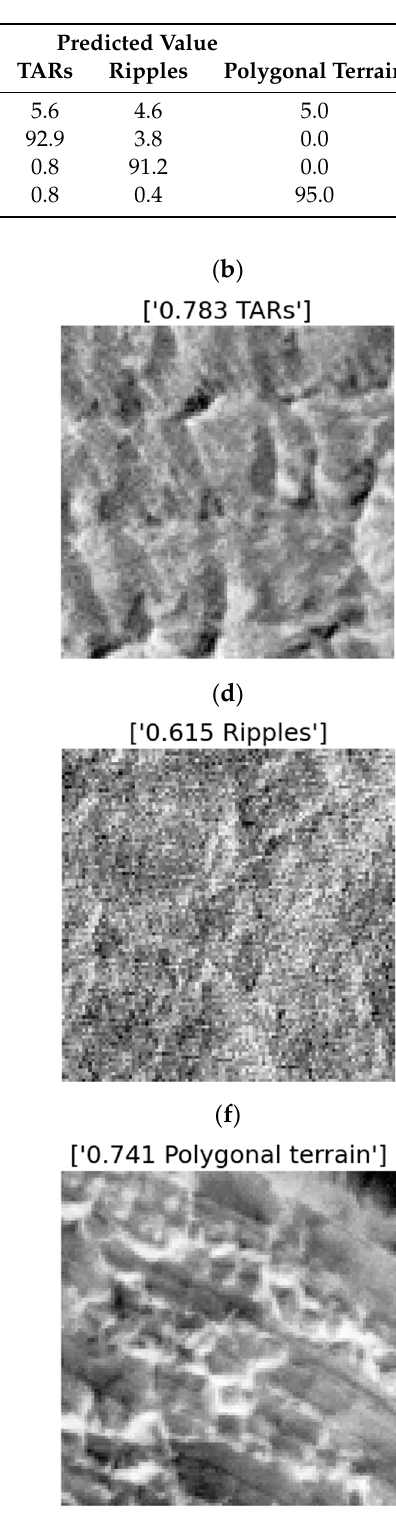
Table 2. The normalized network confusion matrix.